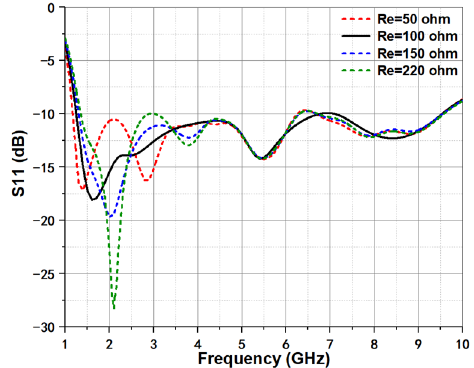
Figure 5. Simulated return loss under different initial radius r 1 of spiral curve.